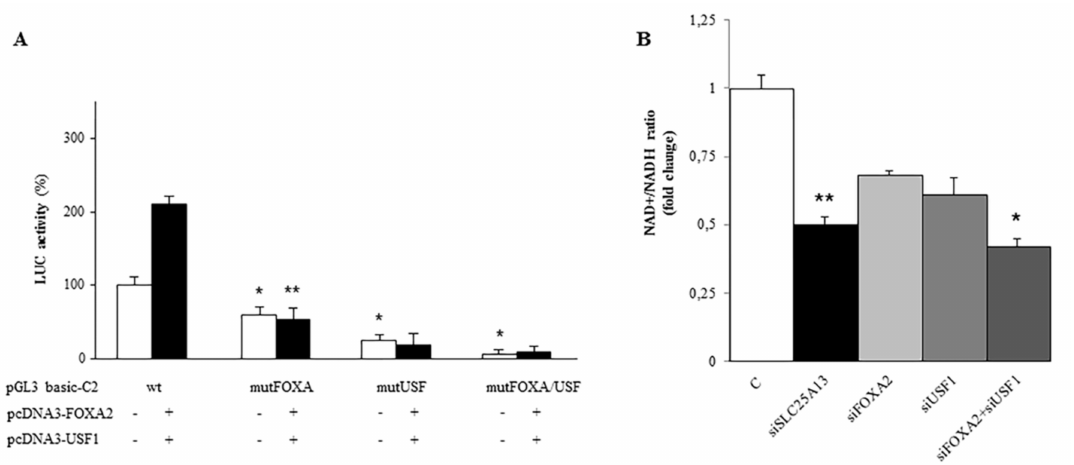
Figure 5. ( A ) Synergy between FOXA2 and USF1. HepG2 cells co-transfected with pGL3 basic-LUC vector containing C2 construct ( − 968 / − 19 of the SLC25A13 gene promoter region) wild-type (wt) or mutated (mutFOXA, mut USF and mut FOXA / USF) in combination with pcDNA3-FOXA2 and pcDNA3-USF1 ( + : black bars) or empty pcDNA3 (-: white bars) were assayed for LUC activity. ( B ) FOXA2 and USF1 e ff ect on AGC2 activity. Quantification of the NAD + / NADH ratio in HepG2 cells transfected with siRNA against FOXA1 and USF1 alone or in combination. siRNA against SLC25A13 was used as control. Where indicated, di ff erences between samples and relative controls were significant (* p < 0.05 or ** p < 0.01 one-way ANOVA followed by Student’s t